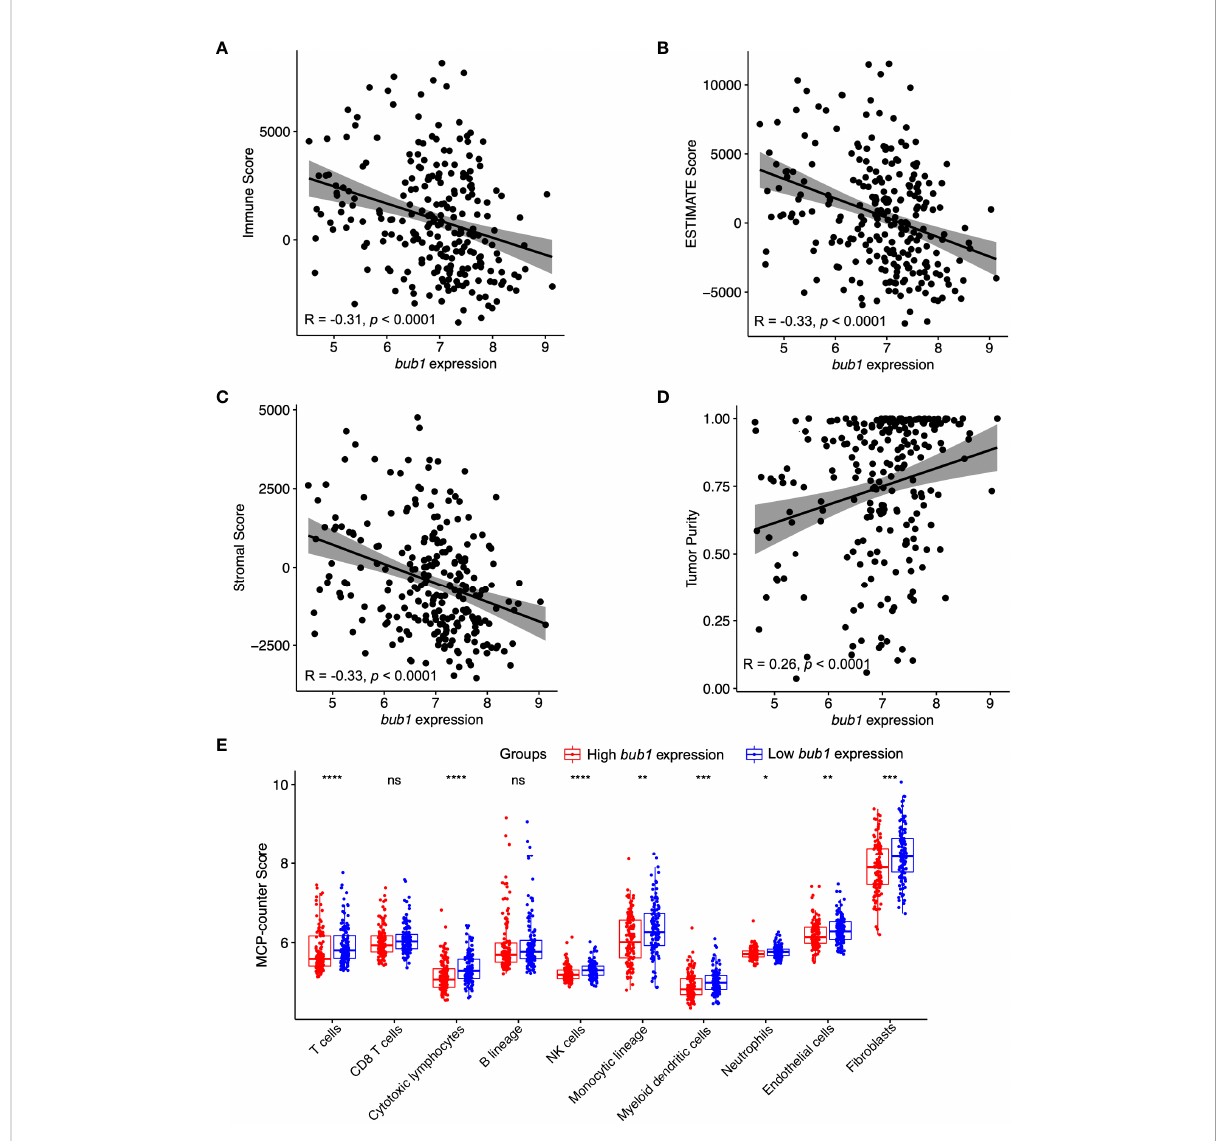
FIGURE 2 Correlation between bub1 gene expression and immune in fi ltration. (A-D) Spearman ’ s correlation analysis revealed moderate negative correlations between bub1 expression and the immune score (A) , ESTIMATE score (B) , and stromal score (C) respectively, and a weak positive correlation between bub1 expression and the tumor purity (D) . (E) Pro fi les of tumor-in fi ltrating immune cells in neuroblastoma microenvironment assessed through MCP-counter algorithm * p ≤ 0.05, ** p < 0.01, *** p < 0.001,**** p < 0.0001, "ns" means “ no sense ” , p >